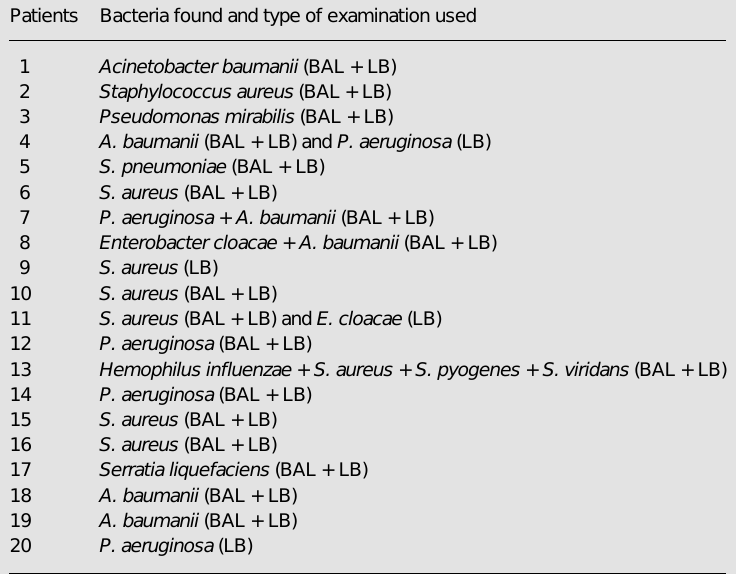
Table 1. Microorganisms isolated from bronchoalveolar lavage and a lung biopsy in 20 cases of ventilator-associated pneumonia. Patients Bacteria found and type of examination